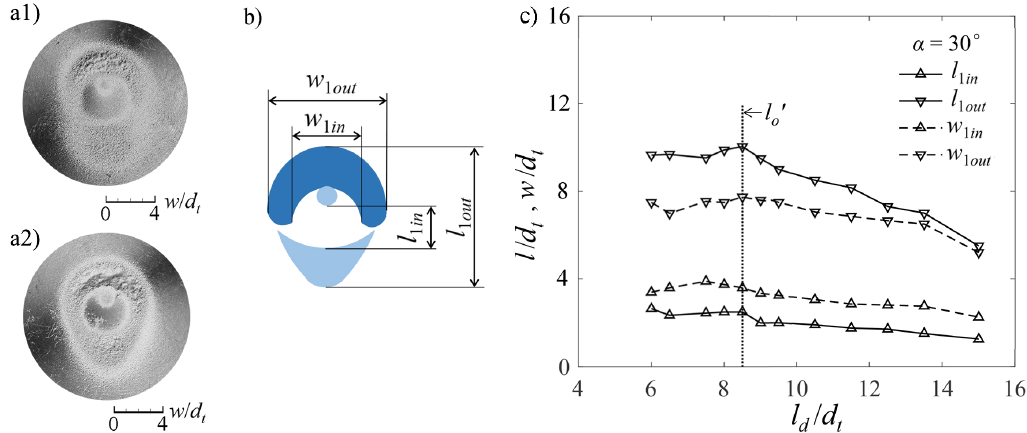
Figure 10. Normal view of eroded surface at α = 30 ◦ : ( a1 ) l d / d t = 6.5, ( a2 ) l d / d t = 10, ( b ) schematic of erosion area, ( c ) erosion